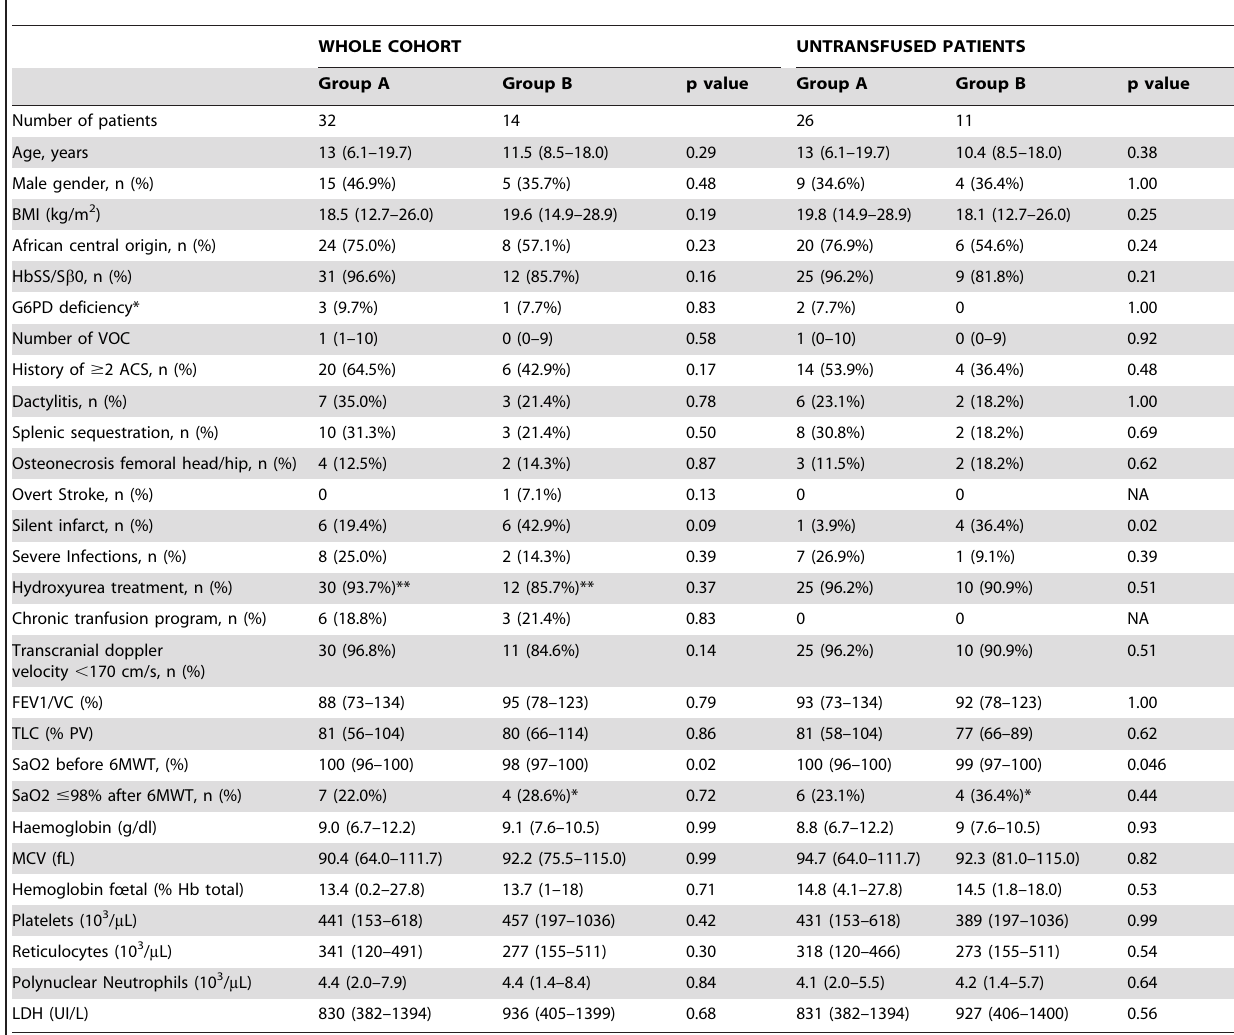
Table 1. Characteristics of patients with normal (Group A) and abnormal (Group B) 6MWT; results represent median (range) unless otherwise